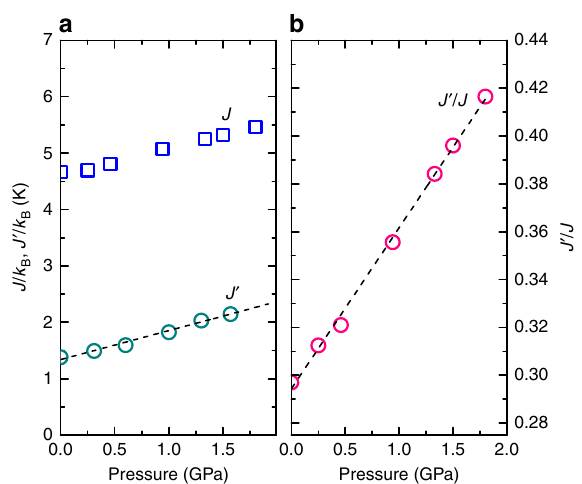
Fig. 2 Pressure-driven tuning of the spin-Hamiltonian parameters in Cs 2 CuCl 4 . a Pressure dependence of the exchange coupling parameters J ′ and J (circles and boxes, respectively). The dashed line corresponds to a linear fi t to the J ′ data (see text for details). b Pressure dependence of the exchange coupling ratio J ′ / J . The dashed line corresponds to a linear fi t to the J ′ / J data (see text for details). Source data are provided as a Source